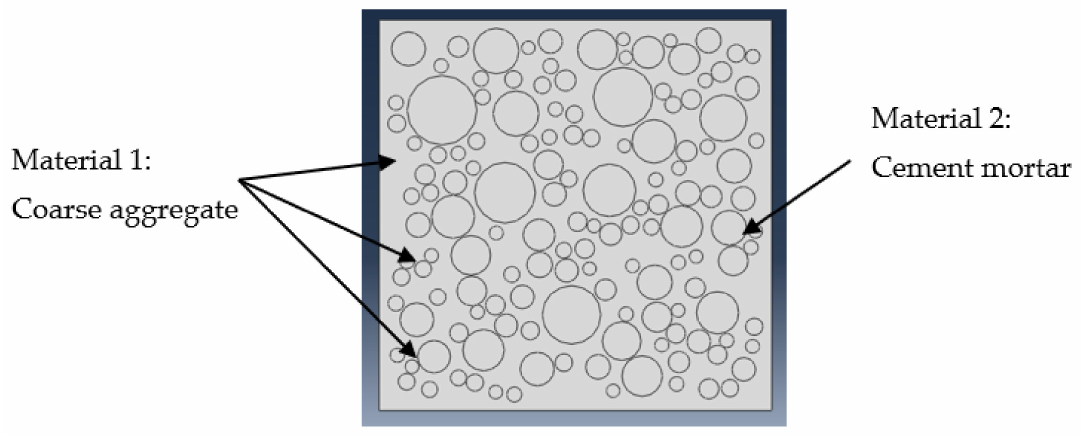
Figure 13. Random aggregate model of concrete in ABAQUS.